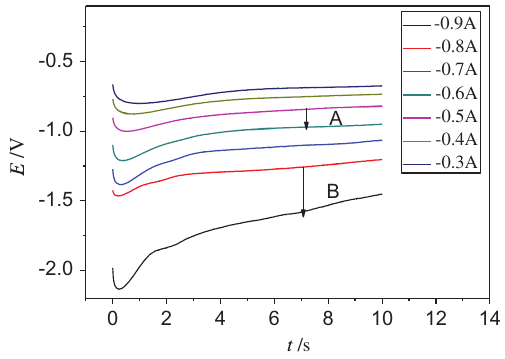
Figure 4: Chronopotentiometry results at different current intensities on a Fe electrode in NaCl-NaF-KCl-SiO 2 ( c SiO2 = 0.177 mol·L − 1 ) melt at 1103 K.